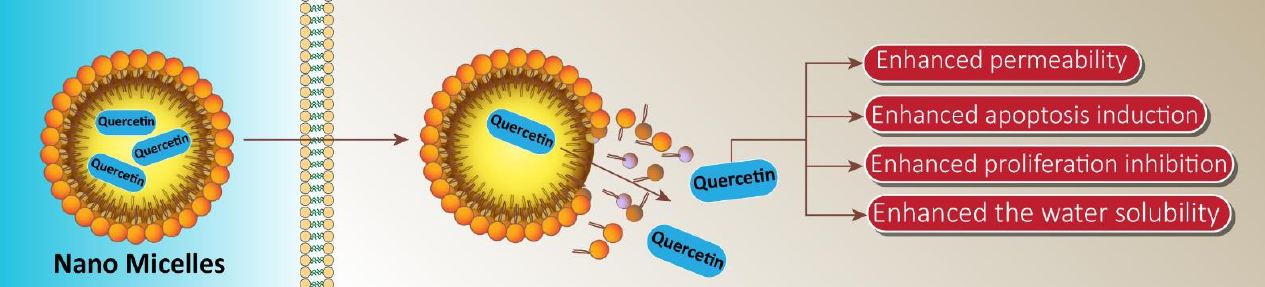
Figure 7. Application of micelles in providing targeted delivery of quercetin in prostate cancer therapy. These nano micelles promote the penetration of quercetin into cancer cells, leading to an increase in bioavailability and subsequent enhancement in suppressing prostate cancer progression and inducing apoptotic cell death.